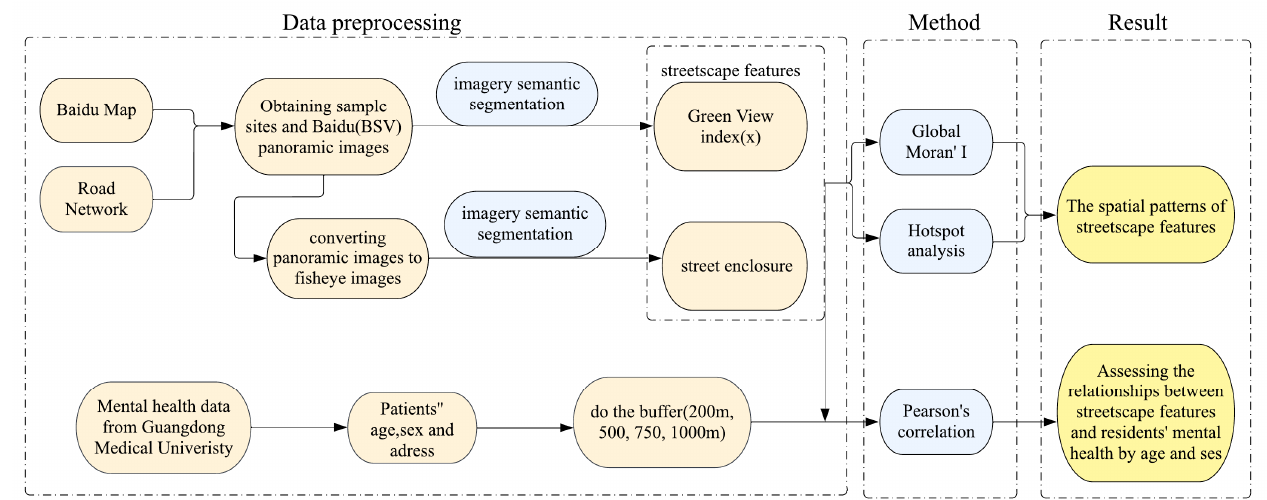
Figure 4. The framework for analyzing the spatial distribution of two streetscape features and their association with mental health. Note: the blue represents input data; the green represents methods; the orange represents the outputs .